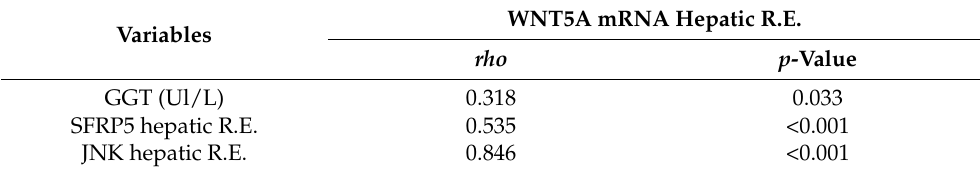
Table 2. Significant correlations between WNT5A relative hepatic expression with clinical and biochemical parameters and with SFRP5 and JNK hepatic expressions. Table 3 . Significant correlations between JNK relative hepatic expression with clinical and bio- chemical parameters and with SFRP5 and JNK hepatic expressions.